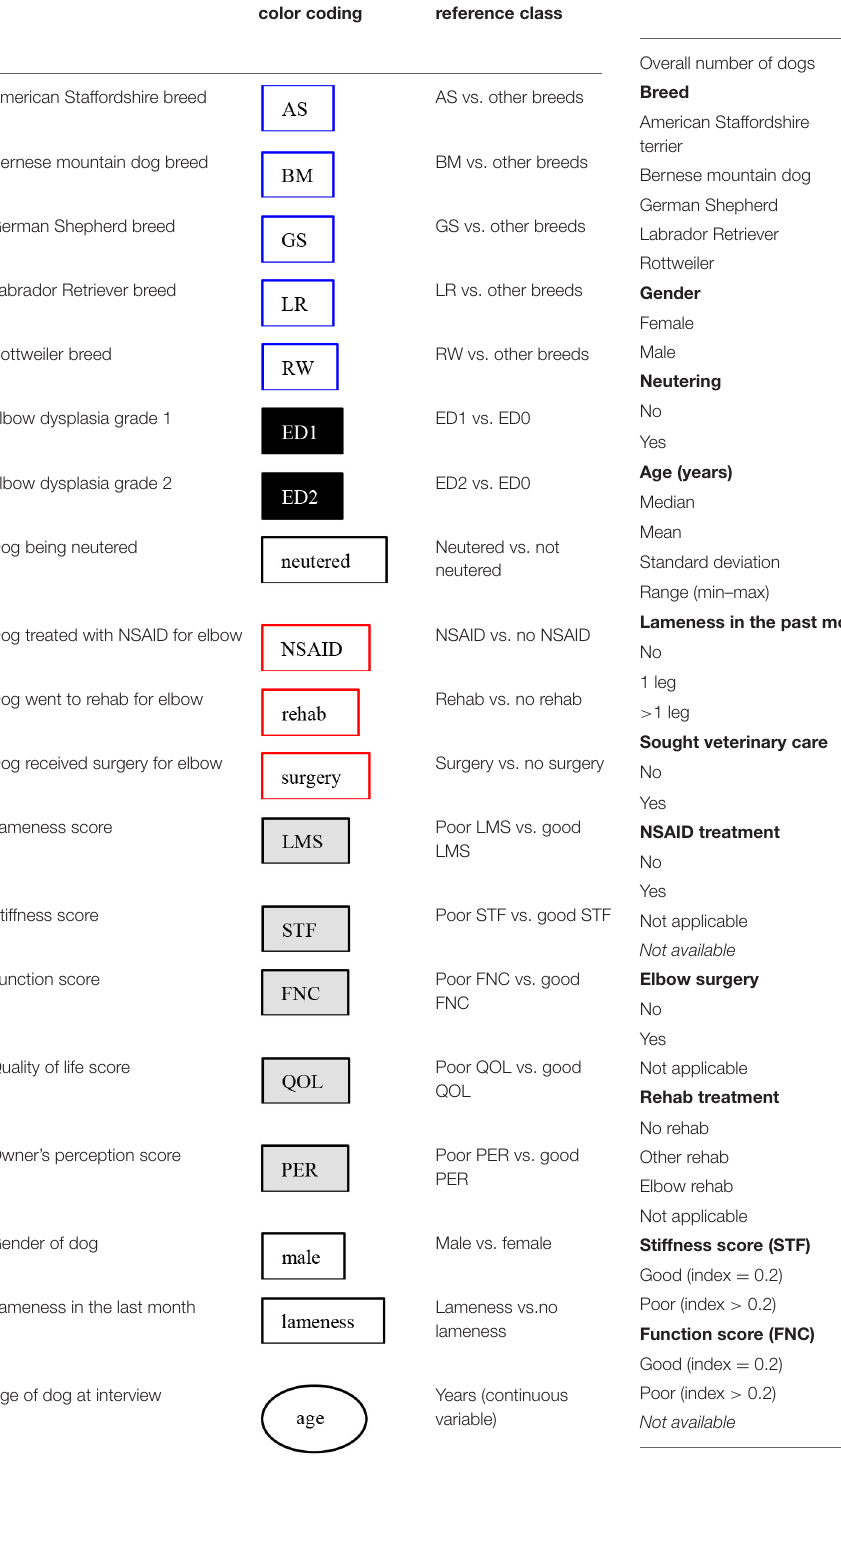
TABLE 3 | Variables included in the additive Bayesian network model. TABLE 4 | Overview of demographic and treatment variables by elbow dysplasia (ED)